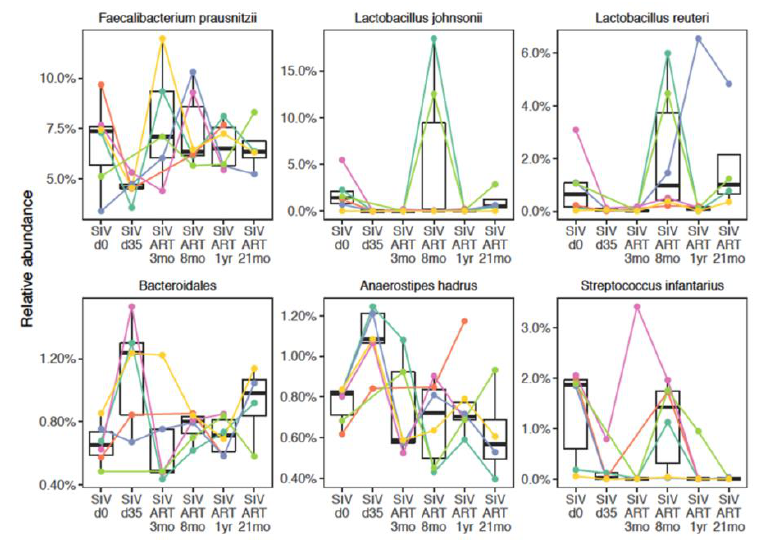
Figure 4. Relative abundance at species level through the course of SIV-ART. Bacterial species showing either a reduction in abundance at d35 post-SIV infection compared to baseline (SIV.d0), and recovery at 3–8 months of ART, or an increase in abundance at d35 post-SIV infection compared to baseline (SIV.d0) and a return to baseline at 3–8 months of